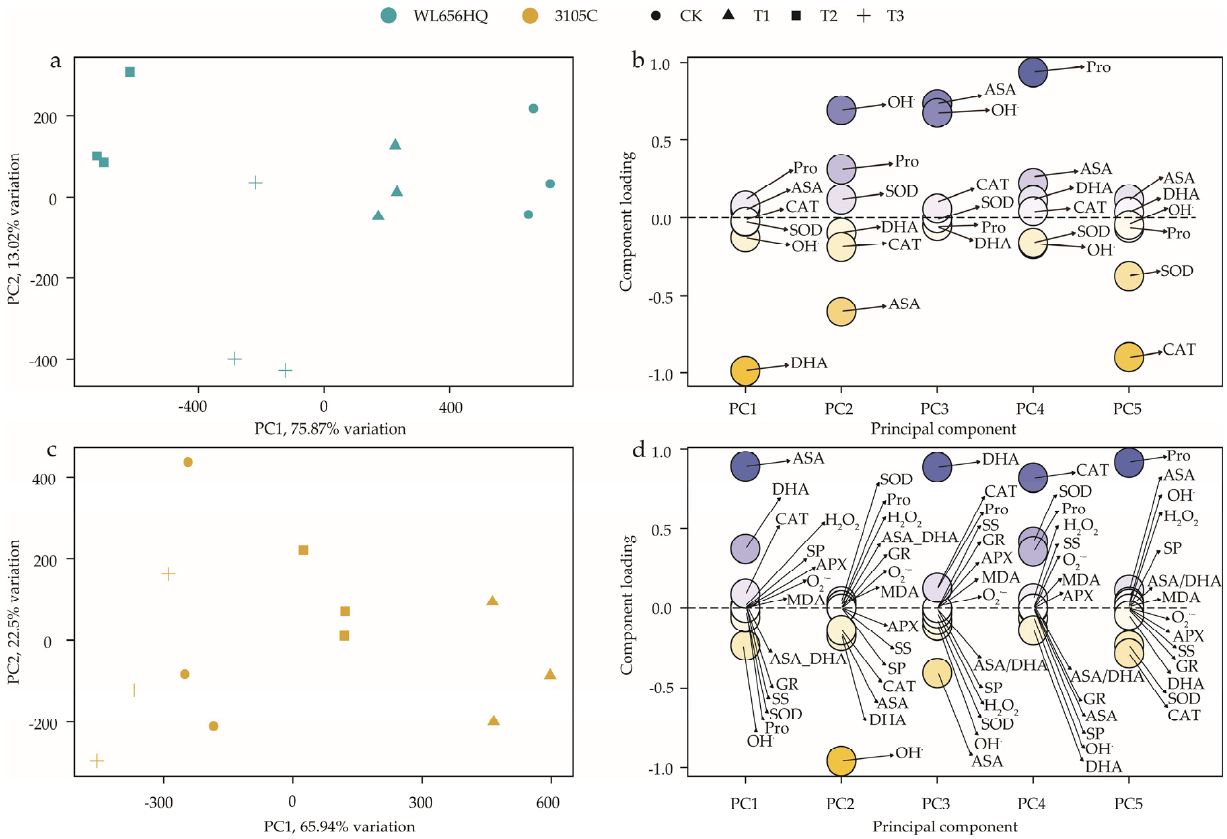
Figure 9. Scores plot (PC1 vs. PC2) of principal component analysis (PCA). ( a ). PCA of WL656HQ. ( b ). Each indicator with component loading in WL656HQ. ( c ). PCA of 3105C. ( d ). Each indicator with component loading in